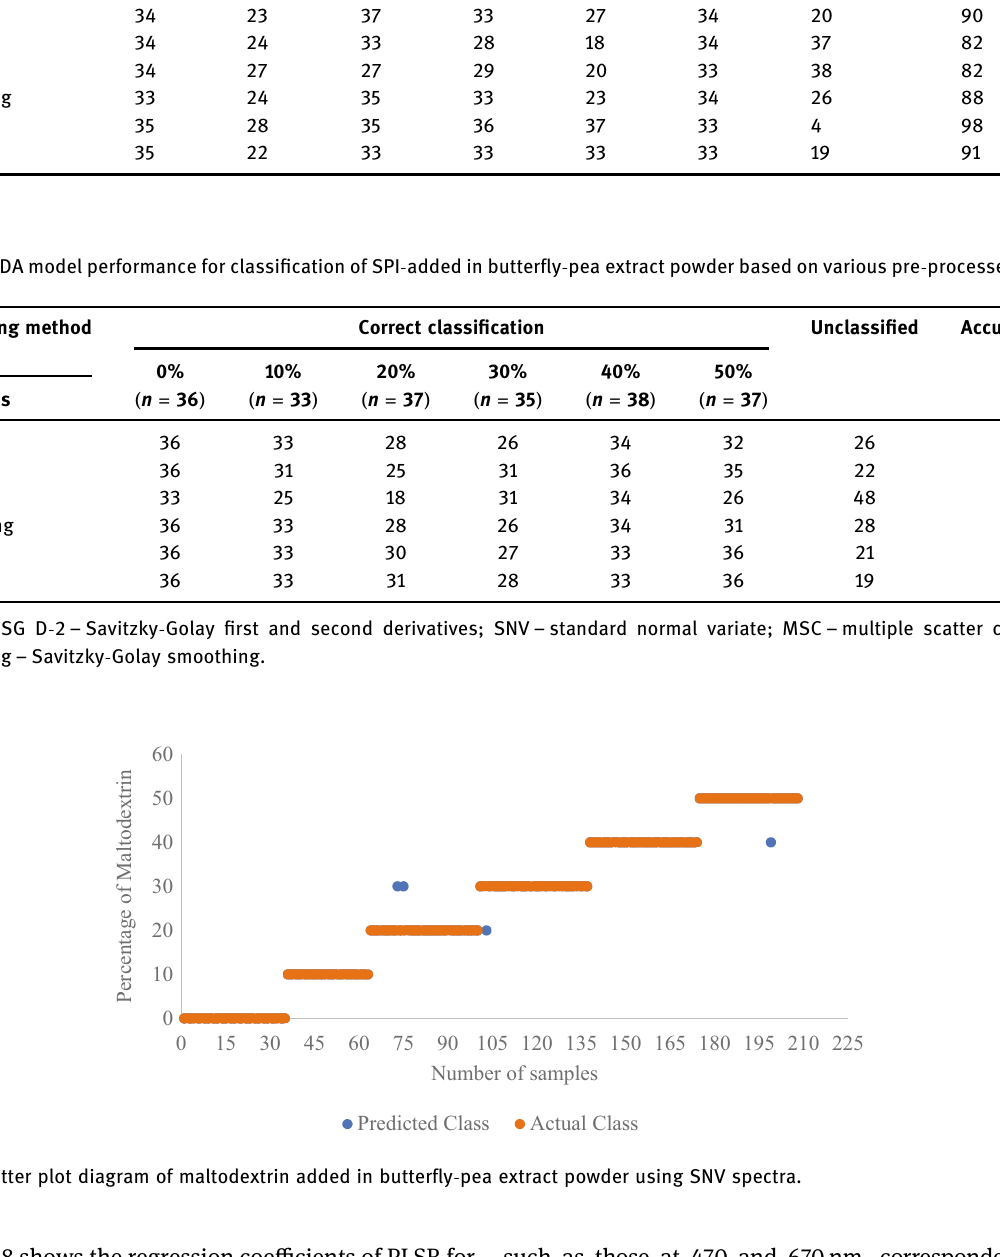
Pre - processing method